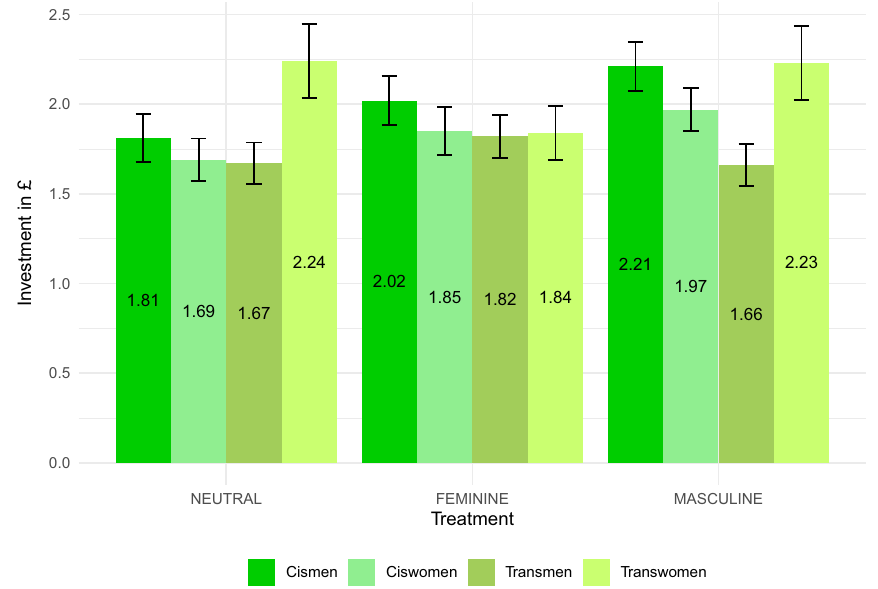
Figure 2. Investments into the risky lottery in Part 5 by treatment and subject groups in alphabetical order ( n = 780 ). The bars show the average investment rate, and the error bars represent the standard errors of the